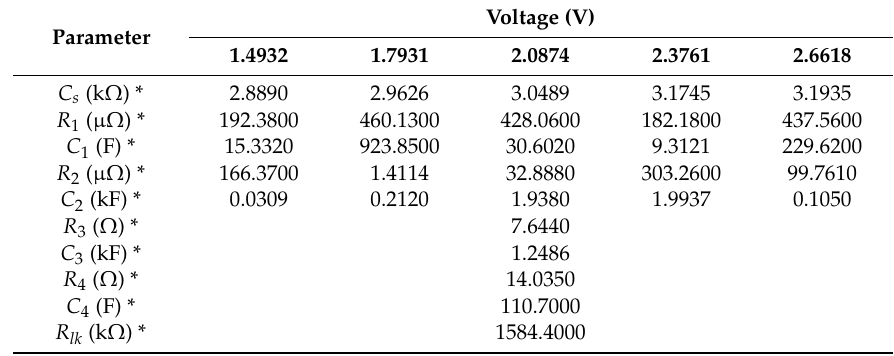
Table A4. Series Model Parameters with current profile i 3 .